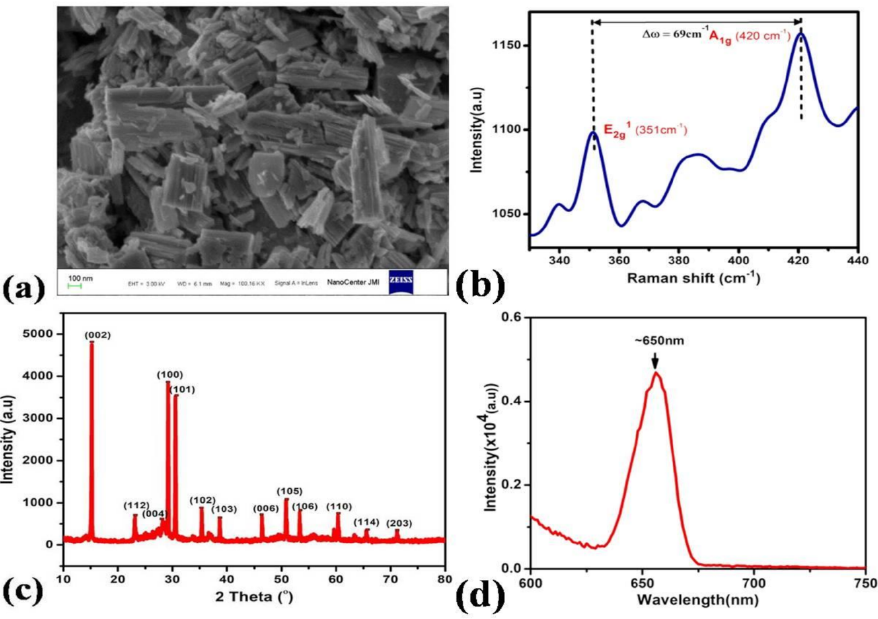
Figure 1. ( a ) SEM images; ( b ) Raman spectrum; ( c ) XRD; ( d ) magnified image of PL spectrumWS 2 NS.